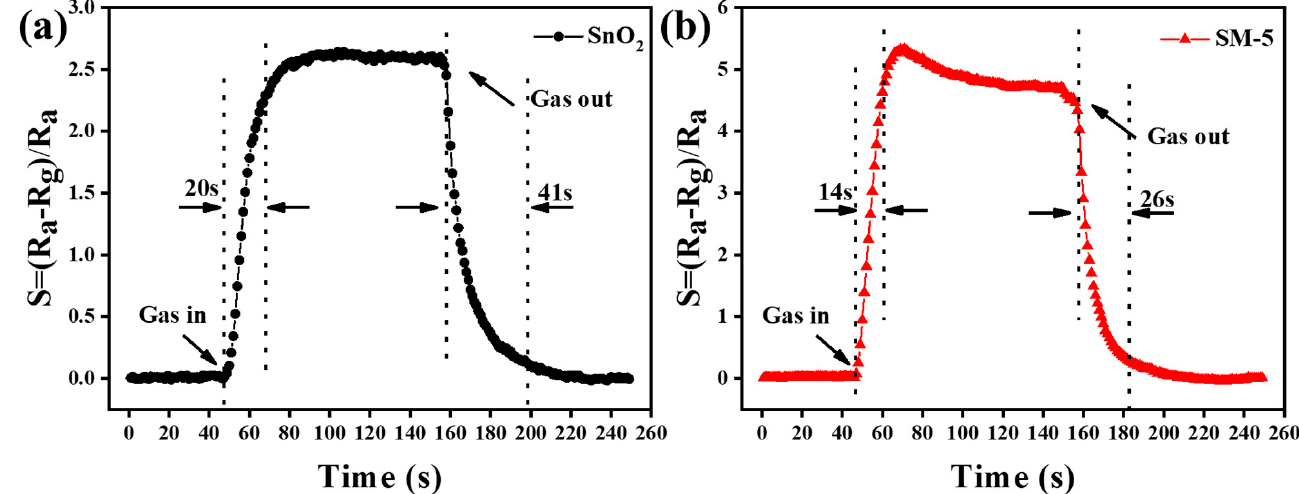
Figure 7. ( a , b ) Response recovery curves of SnO 2 and SM-5 to 10 ppm ethanol.